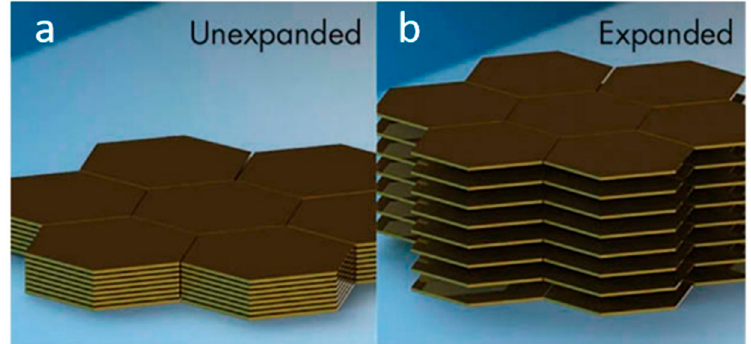
Figure 14. Graphite flakes unexpanded ( a ) and expanded ( b ). [177] Reprinted from “Overview of disbonding technologies for adhesive bonded joints”, A. Hutchinson, Y. Liu, et al. Journal of Adhesion, Vol 93, Pages No. 737–755, Copyright (2016), with permission from Taylor & Francis Ltd., http: //